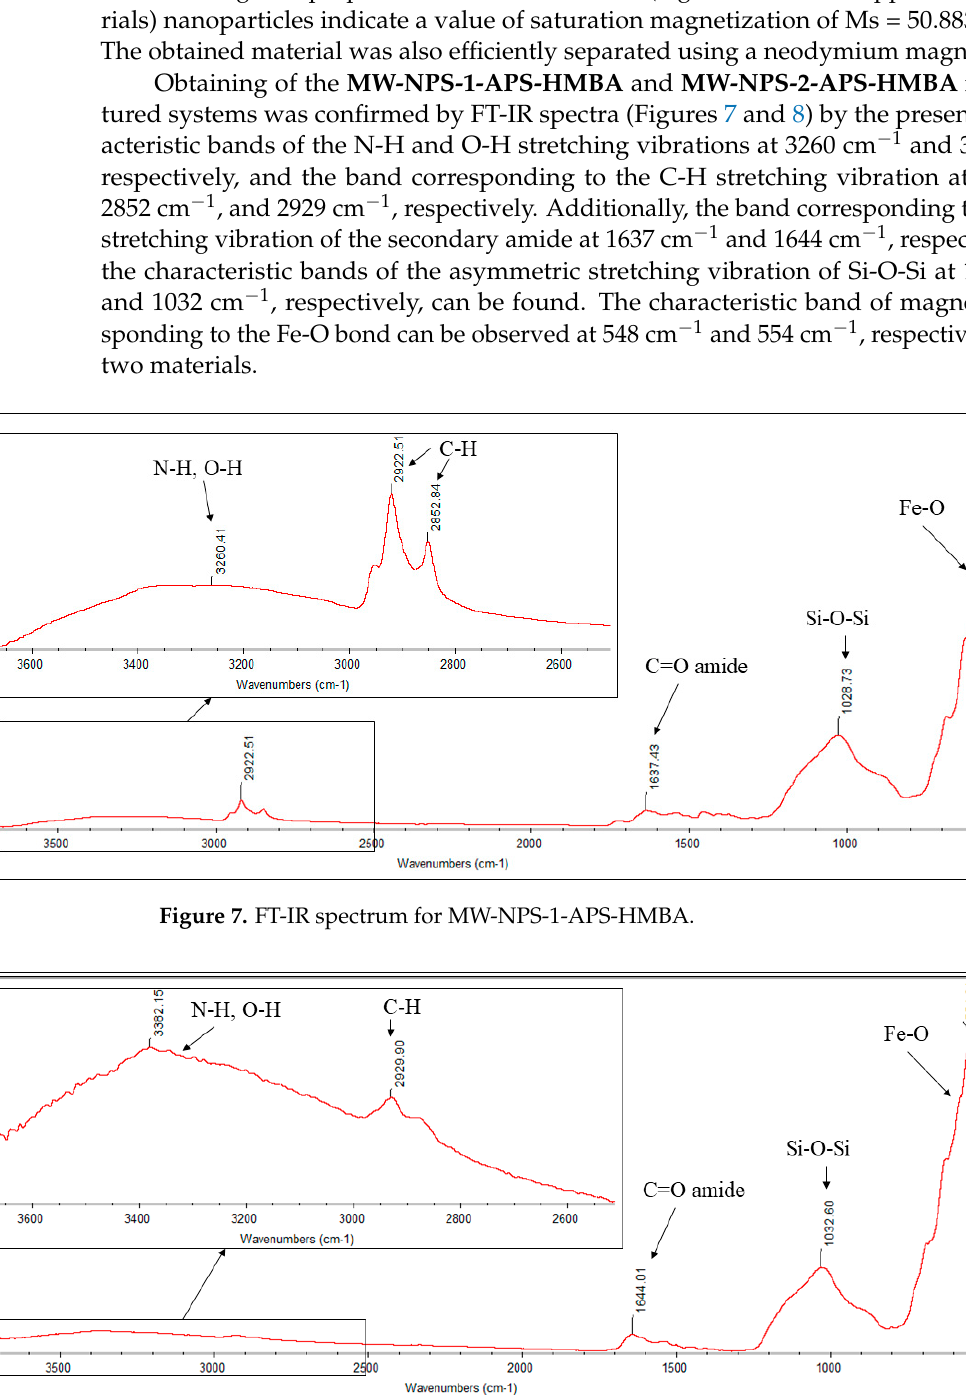
Figure 8. FT-IR spectrum for MW-NPS-2-APS-HMBA.